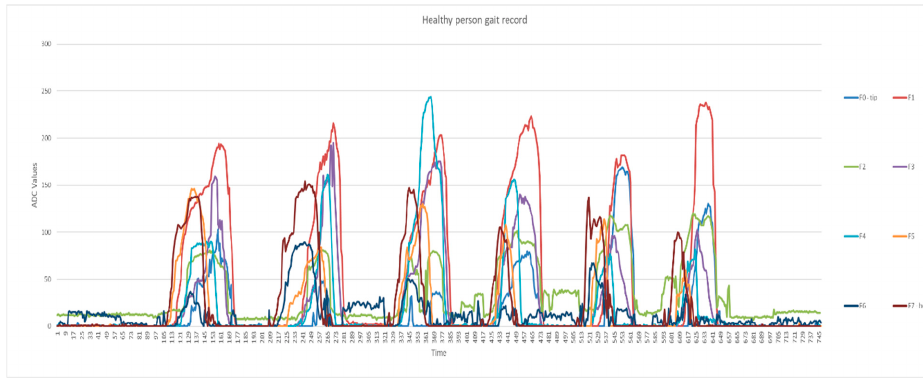
Figure 10. The gait record for a healthy person’s left leg.